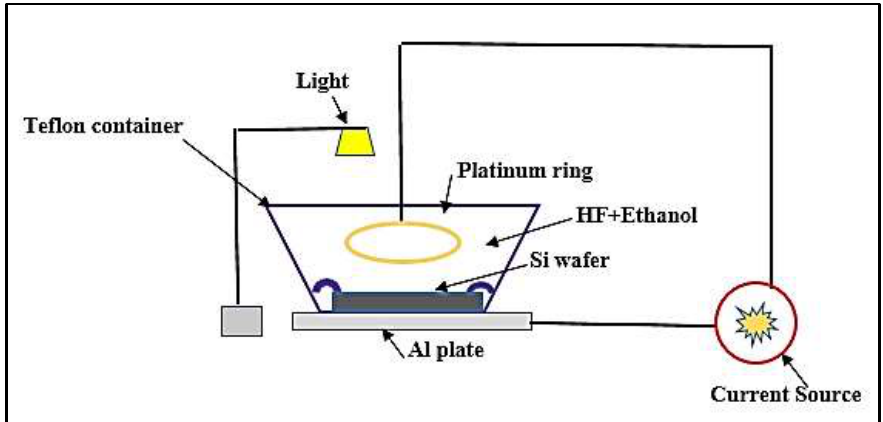
Figure 1: The schematic diagram of the Photoelectrochemical etching